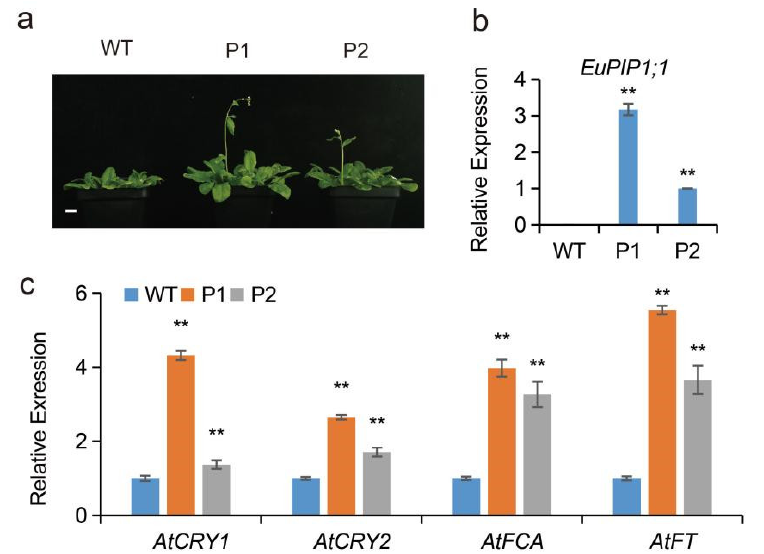
Figure 6. EuPIP1;1 promotes Arabidopsis bolting and flowering. ( a ) Phenotypes of WT and transgenic lines (P1 and P2) grown in soil for 50 d. Bar = 1 cm. ( b ) The expression level of EuPIP1;1 in WT and transgenic lines (P1 and P2). ( c ) The expression level of flowering-related genes in the leaves of WT and P1. (** p < 0.01, one way ANOVA).